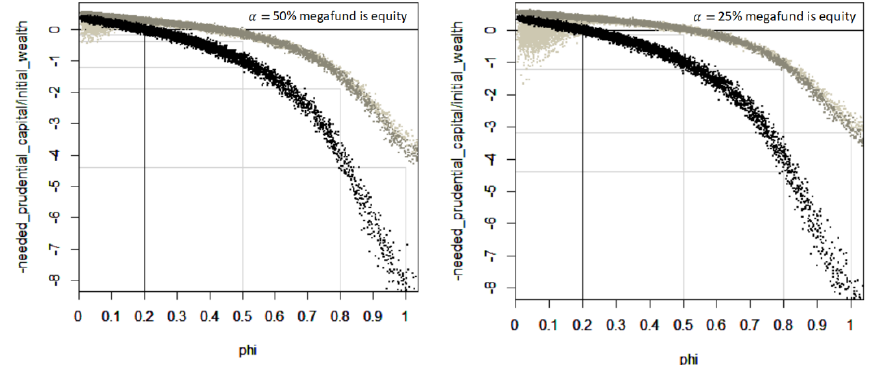
Figure 5. Needed prudential capital, expressed as a proportion of the initial wealth, depending on the future longevity trend and on investments in a longevity megafund. The first graph is for a megafund that uses 50% equity investments, the second graph is for a megafund that uses 25% equity investments. Each dot in the graph is the result of a scenario of the future. In black, no investment is performed in the megafund (p1 = p2 = p3 = 0). In light gray, the pension fund invests in the longevity megafund. In gray, the pension fund invests in the generic biomedical megafund. Table 2. Needed prudential capital, expressed as a proportion of the initial wealth, depending on investments in a longevity megafund.